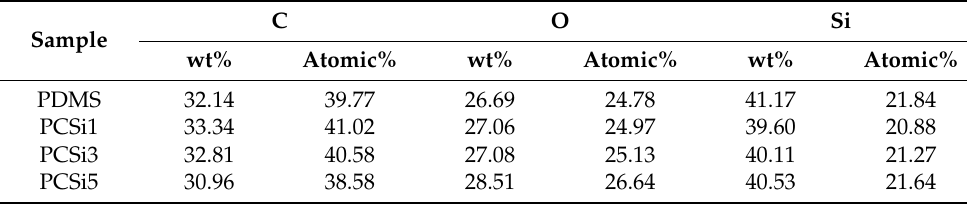
Figure 5. XPS spectra of different samples. Table 2. The contents of different elements in four group samples.